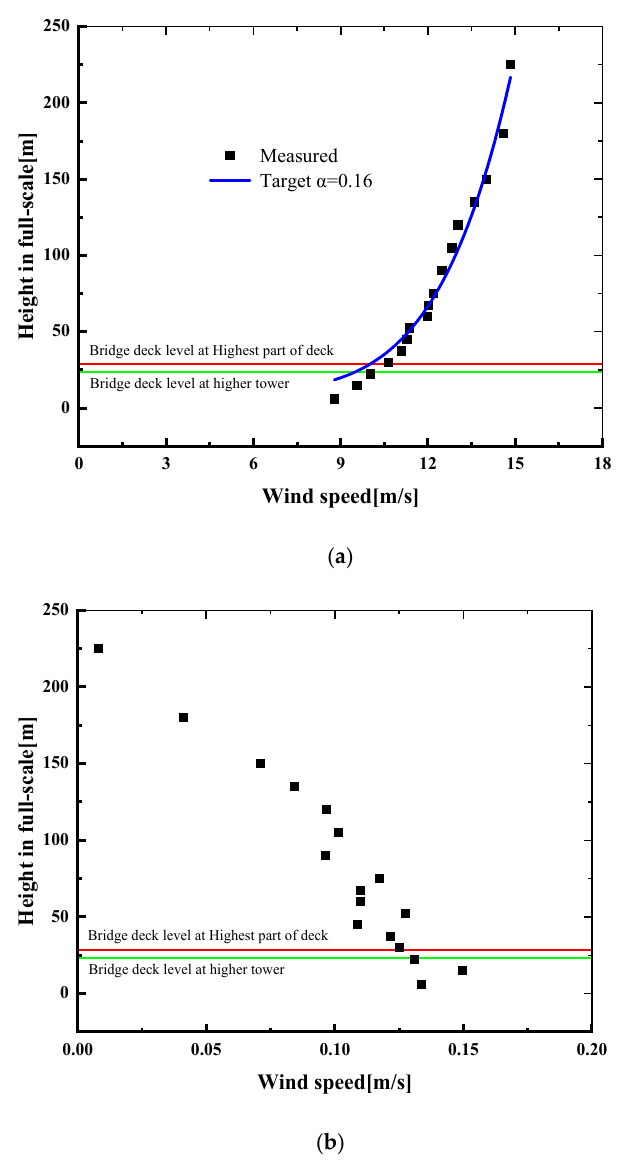
Figure 15. Wind profiles measured in wind tunnel. ( a ) Mean wind speed profiles; ( b ) turbulence intensities profiles.